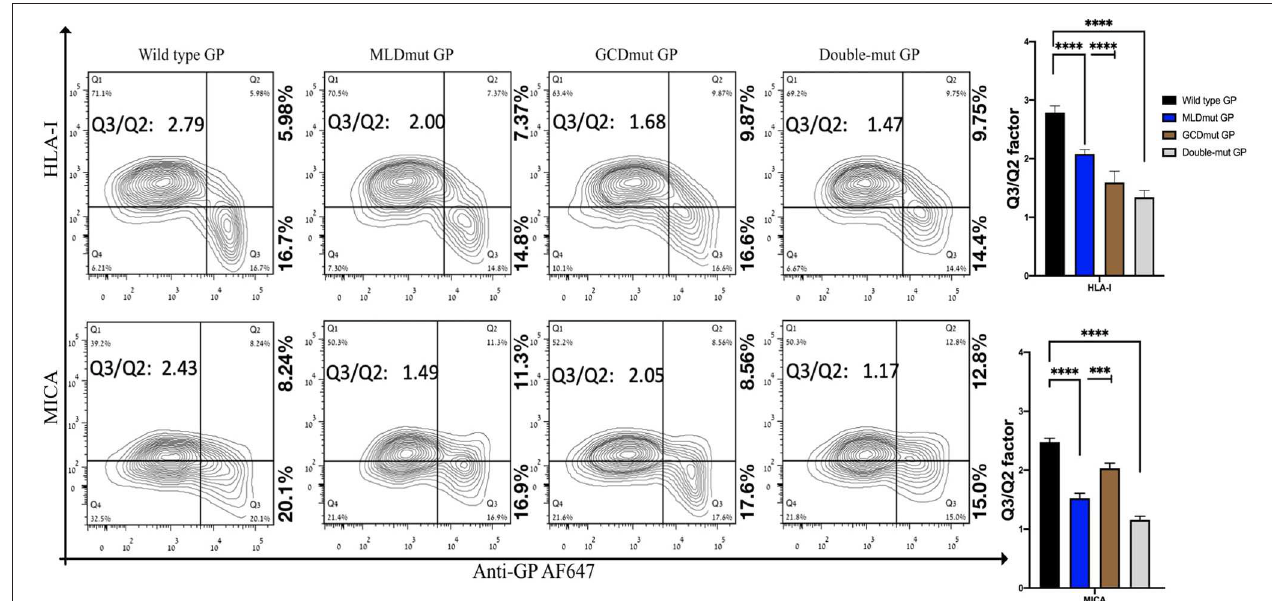
FIGURE 1 | Site-specific mutations, disrupting the N-linked glycosylations in GP1, result in the loss of steric shielding by the EBOV-GP. Flow cytometry analysis shows steric shielding effect over HLA-I (upper panels) and MICA (lower panels) ligands. HEK293T cells were transfected with wild-type GP or with site-specific mutants of GPs with altered N-glycosylation sites (MLD, GCD, or both domains). Thirty hours post transfection, cells (without fixation or permeabilization) were co-stained with mAbs specific for HLA-I or MICA and with mAb specific for EBOV GP (3C10, followed by AF647-labeled secondary). Live cells (7AAD negative) are shown in the contour plots. Q3/Q2 values in the panels are used for evaluating the shielding of MHC-I or MICA by the EBOV GP. End right panels show summary of Q3/Q2 values depicted in the bar chart. Results shown are from one representative analysis of three independent flow cytometry analyses. Graphs representing mean